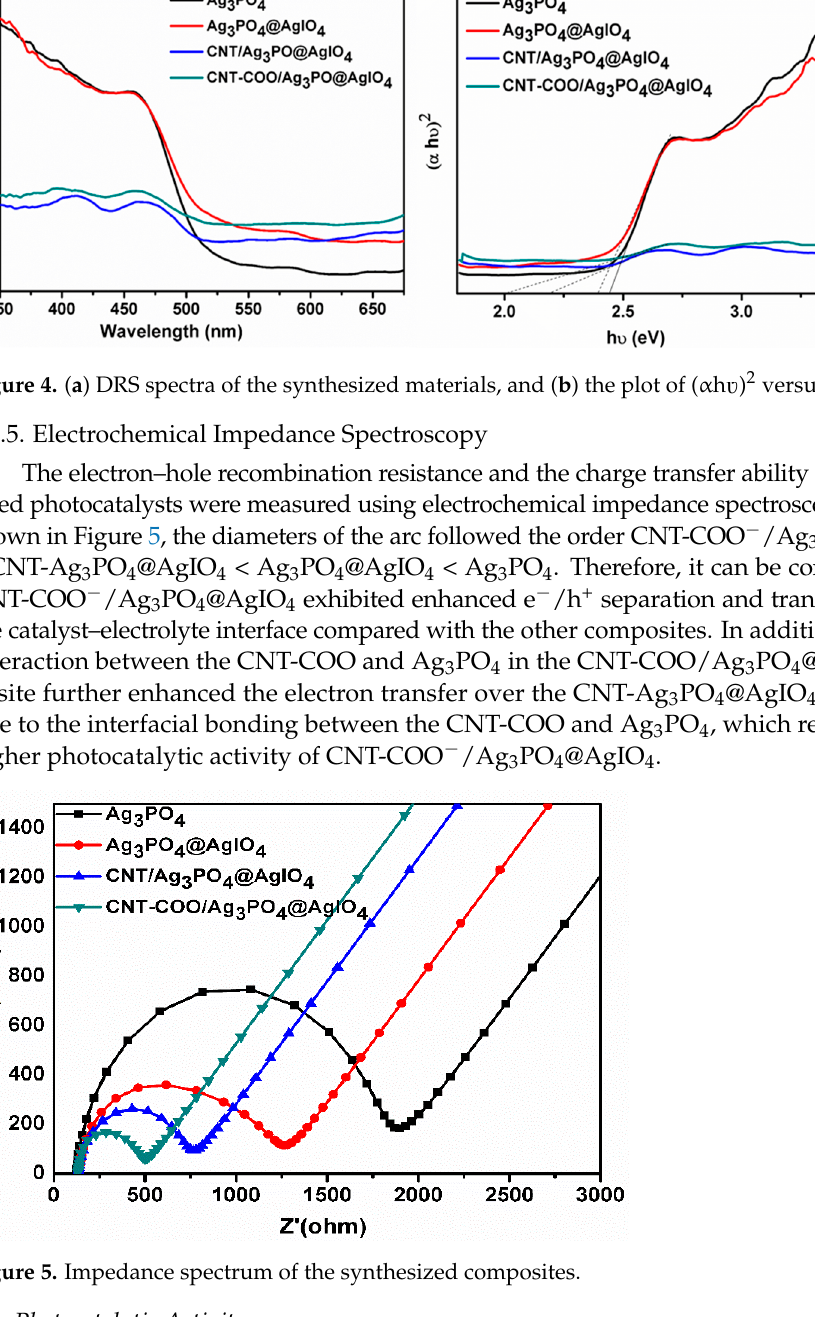
Figure 5. Impedance spectrum of the synthesized composites.